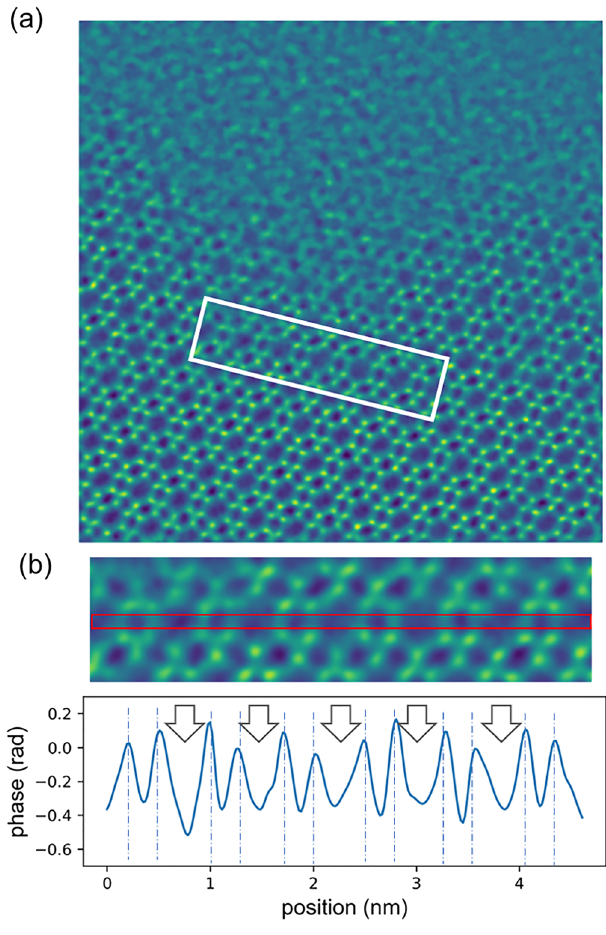
Figure 7. An image of Cu-free CHA reconstructed with zero defocus. ( b ) Line profile taken from the center of the white rectangle in ( a ). The arrows in ( b ) indicate the centers of six-membered rings, and the dotted lines mark the oxygen